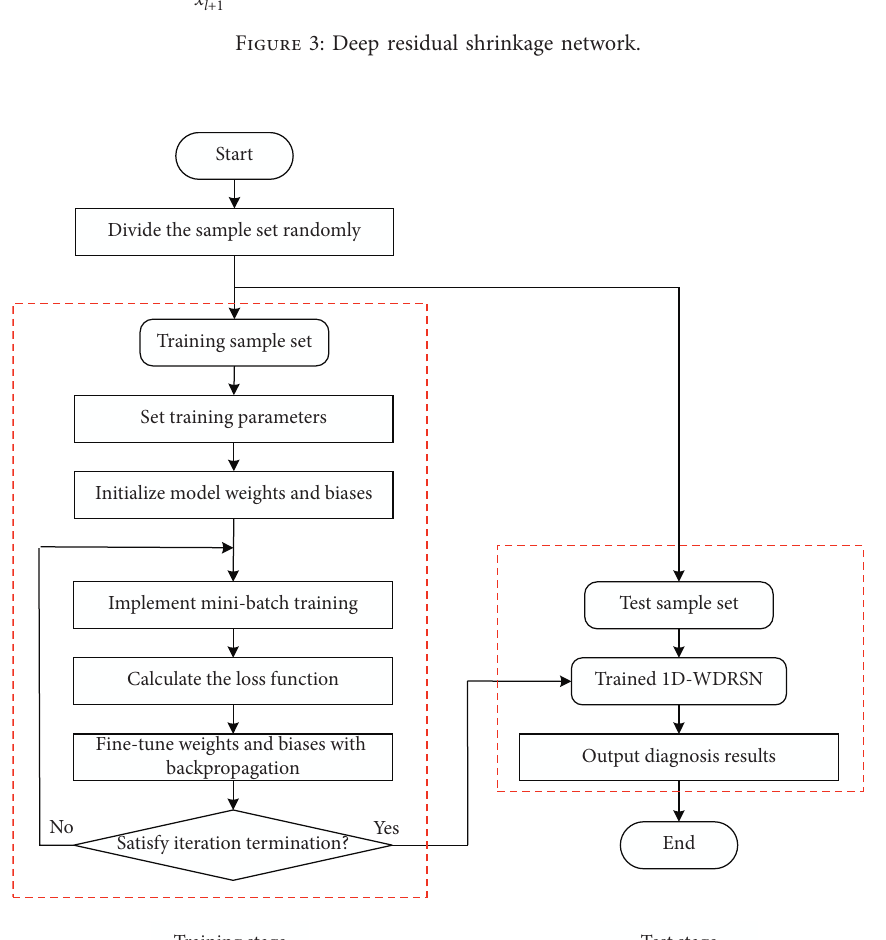
Figure 4: Flowchart of the proposed fault diagnosis model.